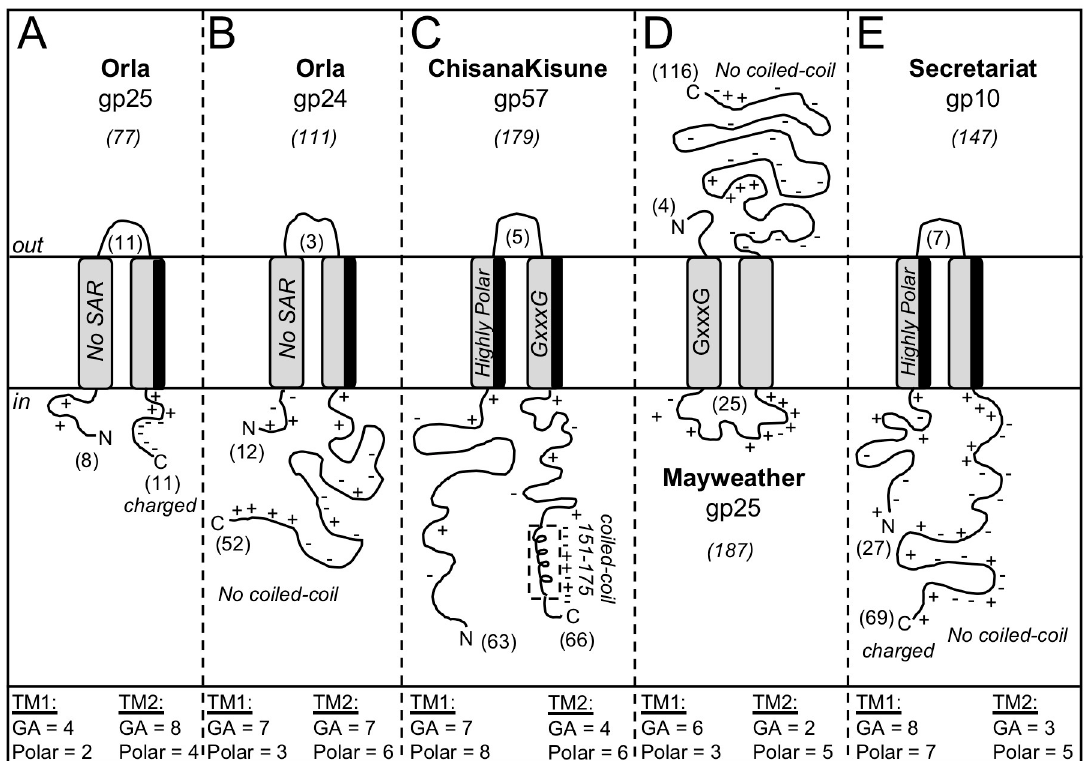
Fig 4. Topologies of proteins with two TM helices from Gordonia phages. TM helices are indicated by the gray areas spanning the membrane. TM helices with dark shading to one side indicate a hydrophilic face. Coiled-coil regions are shown as helix within a dashed box. Amino acid characteristics of TM1 and TM2 are shown in the bottom panel: GA = number of glycine and alanine residues in the helix; Polar = number of polar residues in the helix (STYQNDEKHR). N = N-terminal; C = C-terminal;+ = location of a positive residue (RKH);— = location of a negative residue (DE); numbers in parenthesis indicate the number of amino acids in a given domain or the size of the reference protein above the phage name. SAR = Signal arrest release sequence. GxxxG = the presence of a GxxxG region in the TM